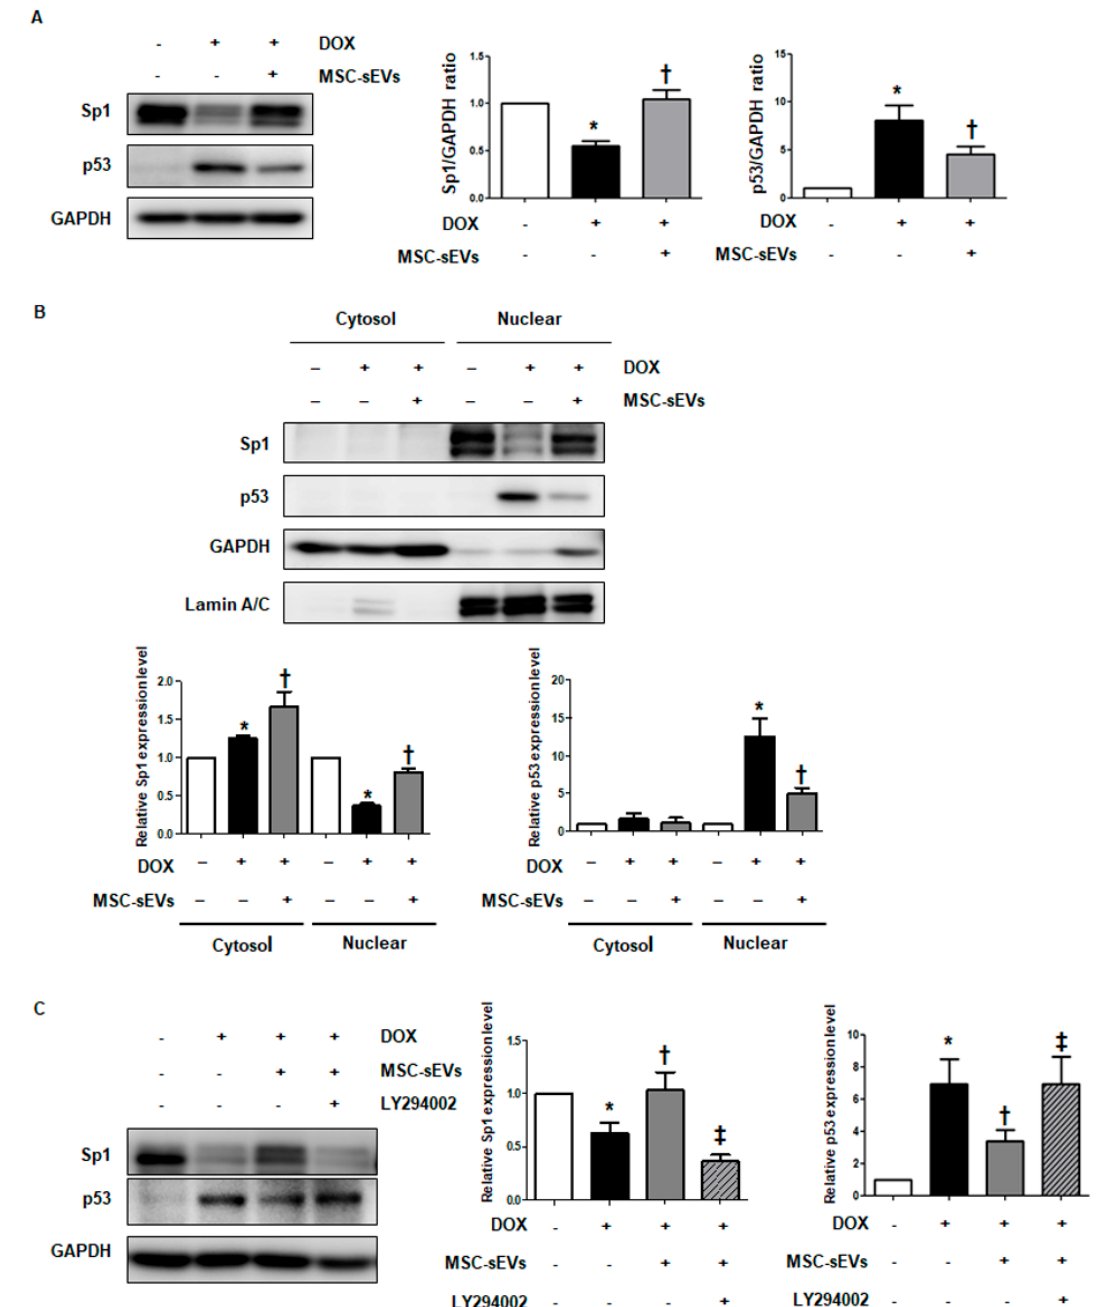
Figure 4 . Akt activation by MSC − sEVs induces survivin by downregulating p53 and upregulating Sp1. H9c2 cells were pretreated with MSC − sEVs for 24 h and then incubated with DOX (1 μ M) for 24 h. ( A ) The protein levels of Sp1, p53, and GAPDH were measured by Western blotting ( n = 5). * Significant difference compared to the control ( p < 0.05). † Significant difference compared to DOX treatment ( p < 0.05) . ( B ) Cytoplasmic and nuclear extracts were isolated from H9c2 cells under each condition. The protein levels of Sp1, p53, GAPDH, and lamin A/C were detected by Western blotting ( n = 5). GAPDH and lamin A/C were used as internal controls for the cytosolic and nuclear fractions, respectively. * Significant difference compared to the control ( p < 0.05). † Significant difference compared to DOX treatment ( p < 0.05) . ( C ) After pretreatment with LY294002 (50 μ M) for 2 h, H9c2 cells were exposed to MSC − sEVs for 24 h and then treated with DOX (1 μ M) for 24 h. The protein levels of Sp1, p53, and GAPDH were measured by Western blotting ( n = 5). * Significant difference compared to the control ( p < 0.05). † Significant difference compared to DOX treatment ( p < 0.05) ‡ Significant difference compared to MSC − sEVs + DOX treatment ( p < 0.05).